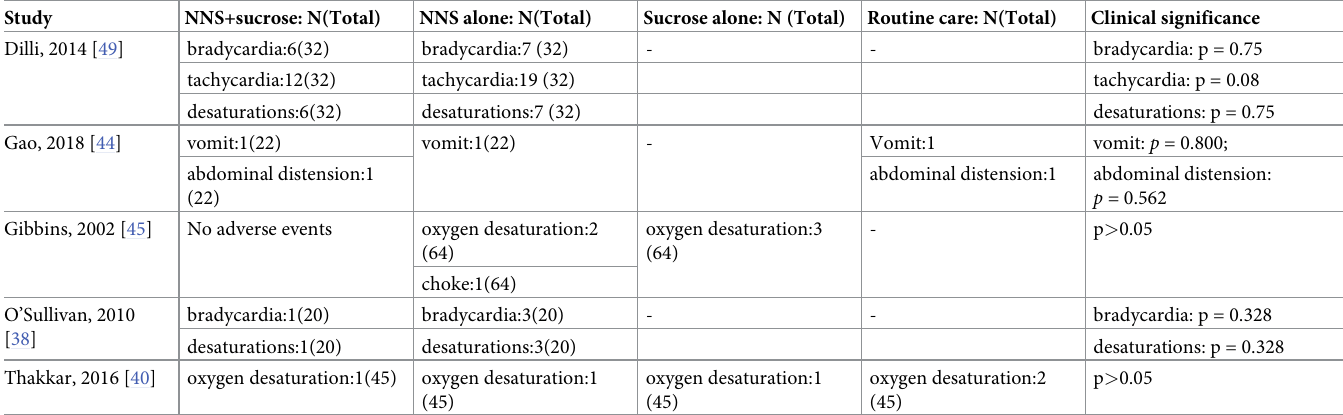
Table 2. Episodes of adverse events in included studies.